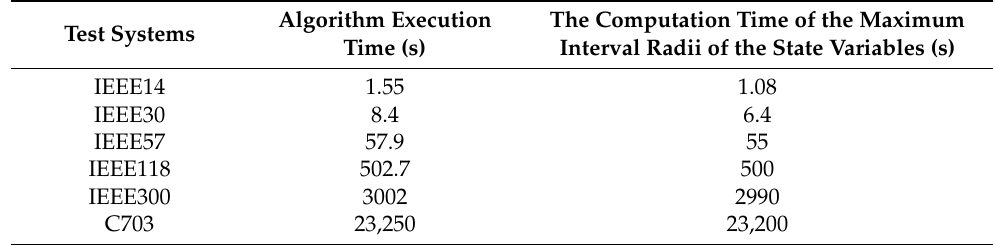
Table 3. The IRPO algorithm based on the MSLM to test the calculation time of different EPS.